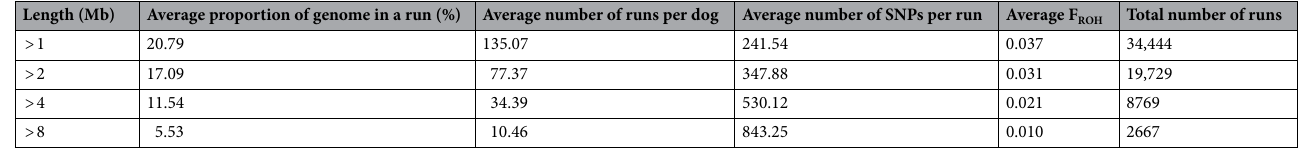
Table 4. Summary of runs of homozygosity analysis based on 255 genotyped dogs. F ROH = inbreeding coefficient calculated from runs of